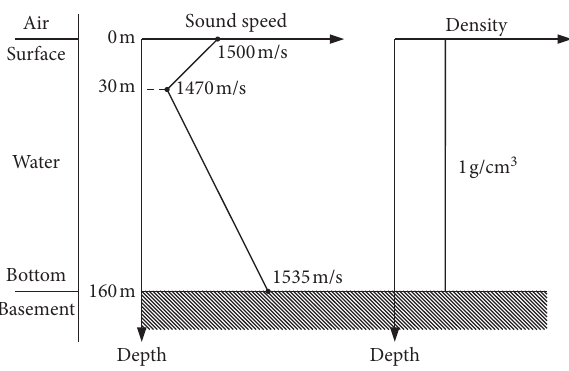
Figure 5: Sound speed profile and density in the test case.